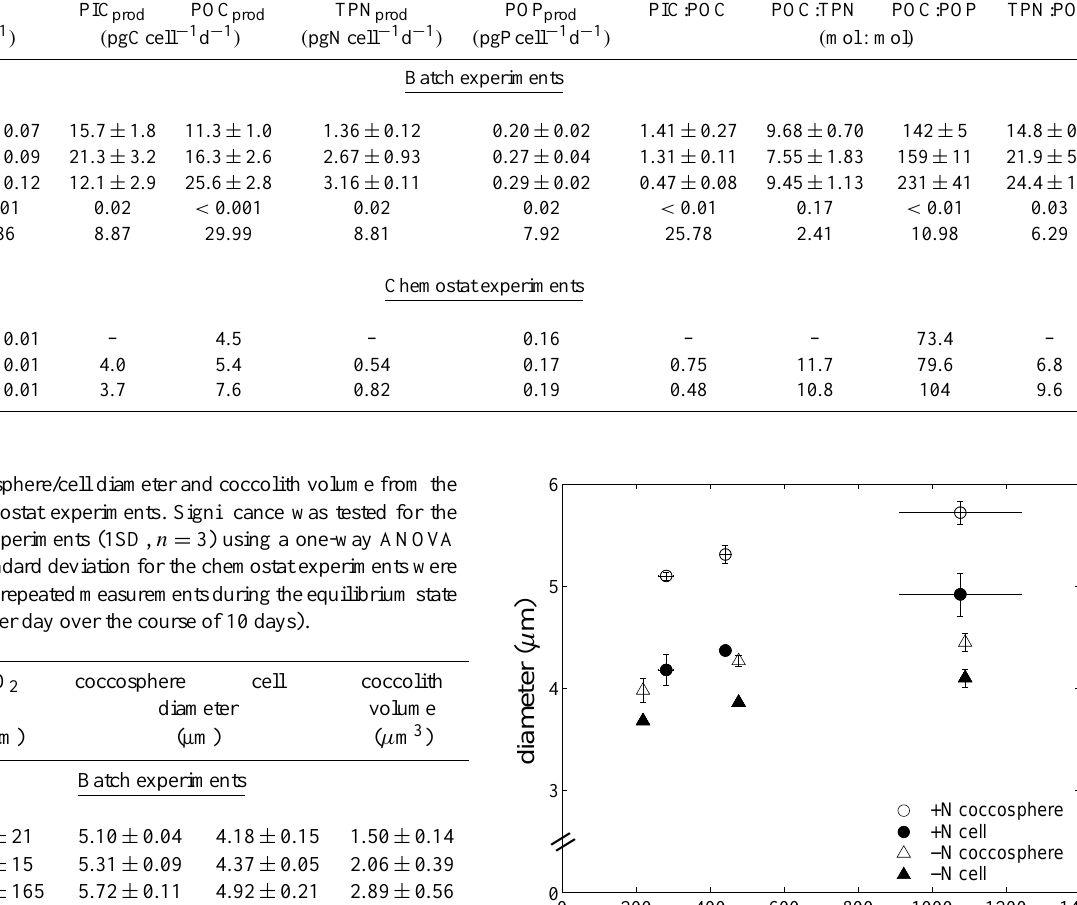
Table 3. Physiological parameters and cellular ratios of the batch (1SD, n = 3) and chemostat experiments. Significance was tested for the batch culture experiments using a one-way ANOVA ( p < 0 . 05). exp.